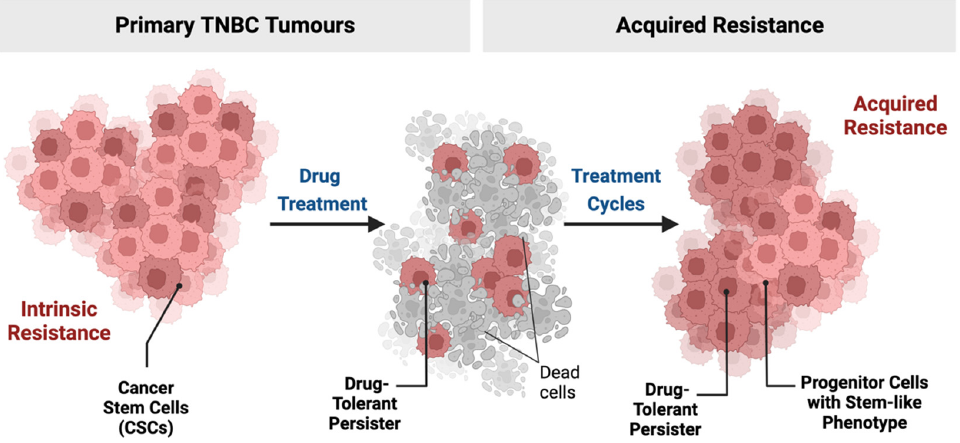
Figure 2. TNBC tumours exhibit intrinsic resistance to therapy due to the presence of cancer stem cells as well as acquired resistance after treatment cycles. Created with BioRender.com, agreement number QB248V9UMD.